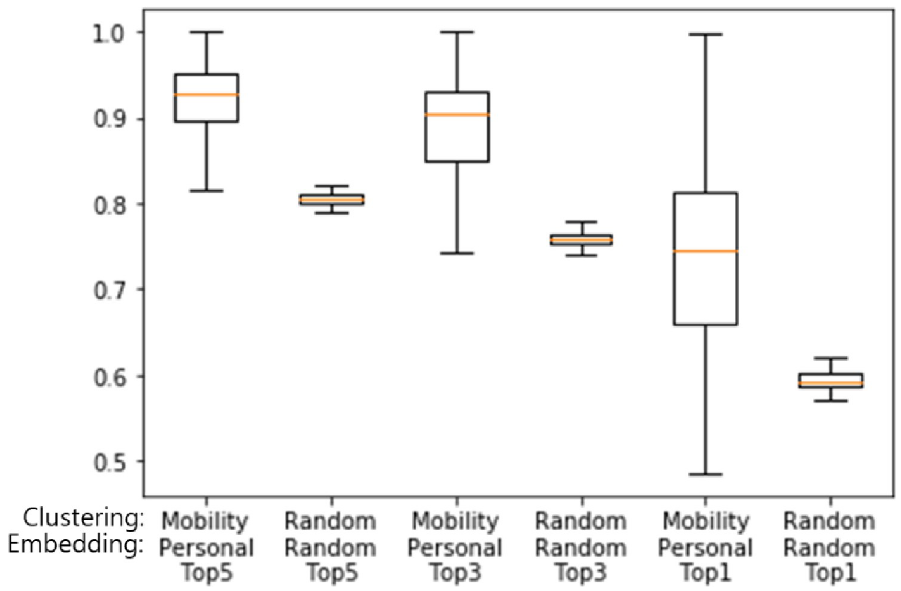
Fig 7. Results of 10-fold cross validation for verifying the performances of the proposed method and baseline methods. The y axis represents accuracy.